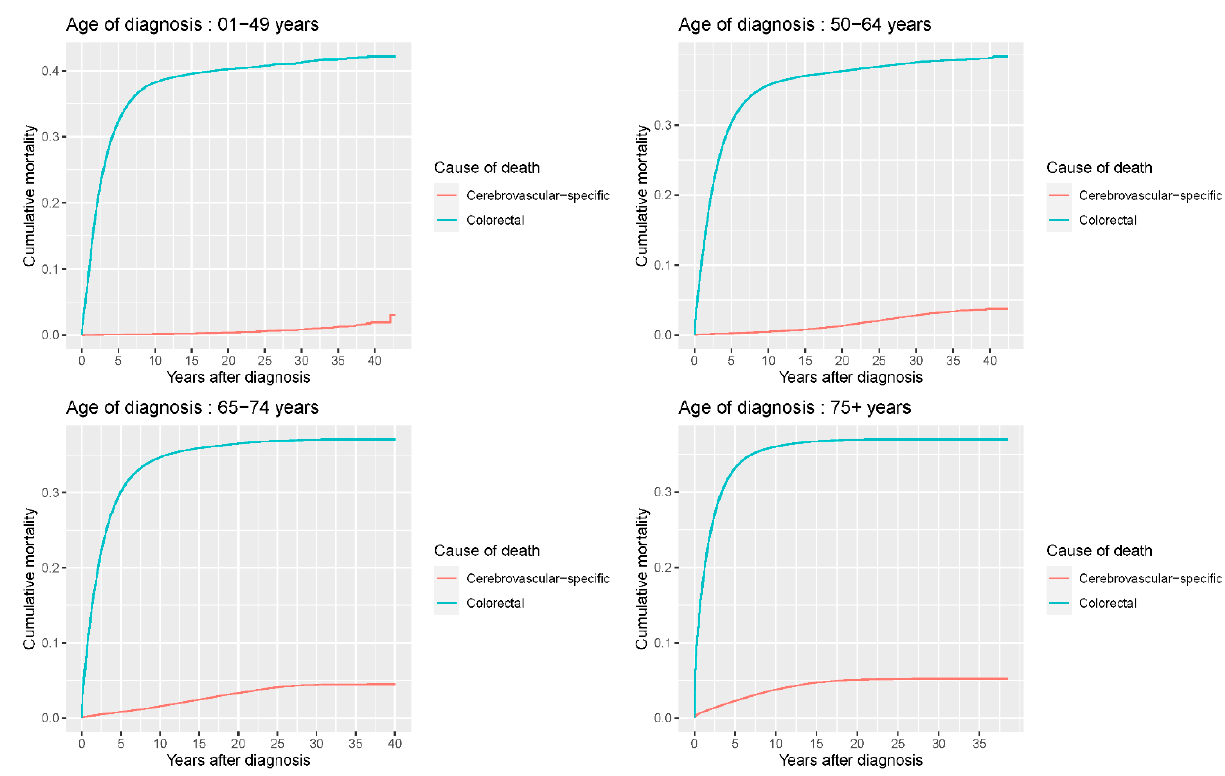
Figure 3. Univariate analyses using a competing risk model showed a significant association of pa- tient age with CVSM in CRC patients ( p < 0.0001). Patients were separated into four subgroups (<50/50–64/65–75/ ≥ 75 years) according to age, and crude cumulative mortality functions were com- puted and plotted for cerebrovascular-specific and colorectal cancer-specific mortality for each subgroup to display the probability of experiencing CVSM- or CRC-specific deaths in the presence of competing events. Differences in cumulative mortality among different subgroups were analyzed by Gary’s test.